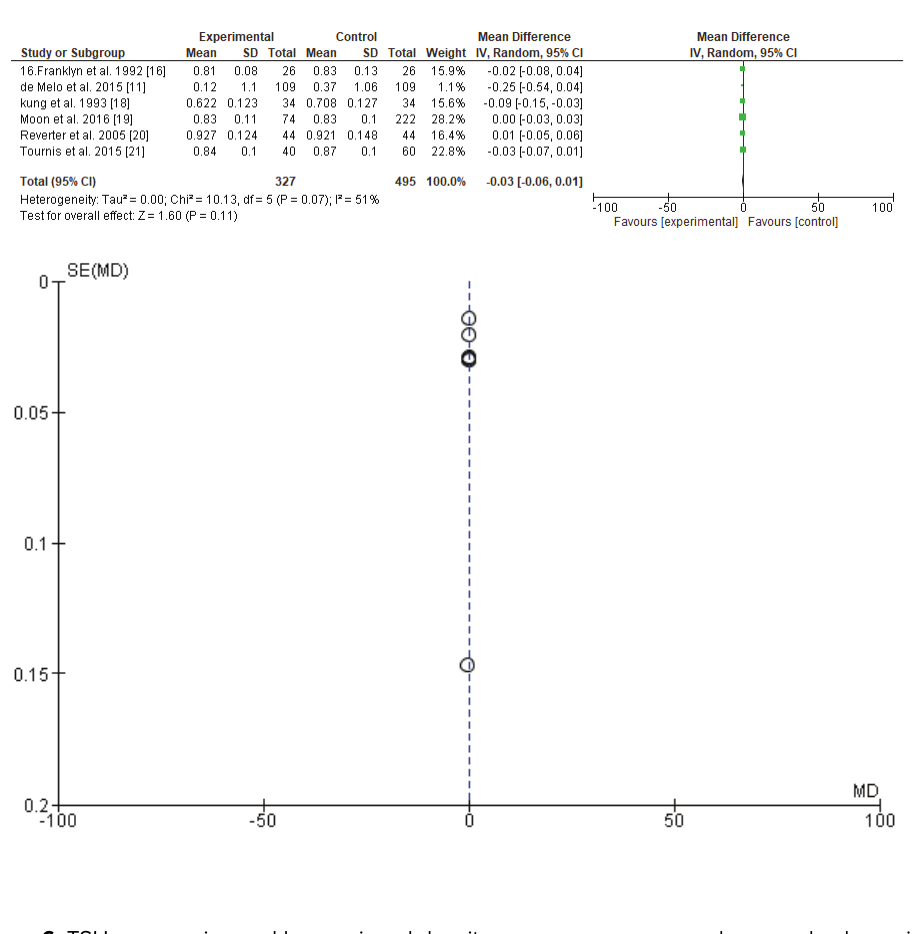
Figure 6 : TSH suppression and bone mineral density among premenopausal women lumbar spines.